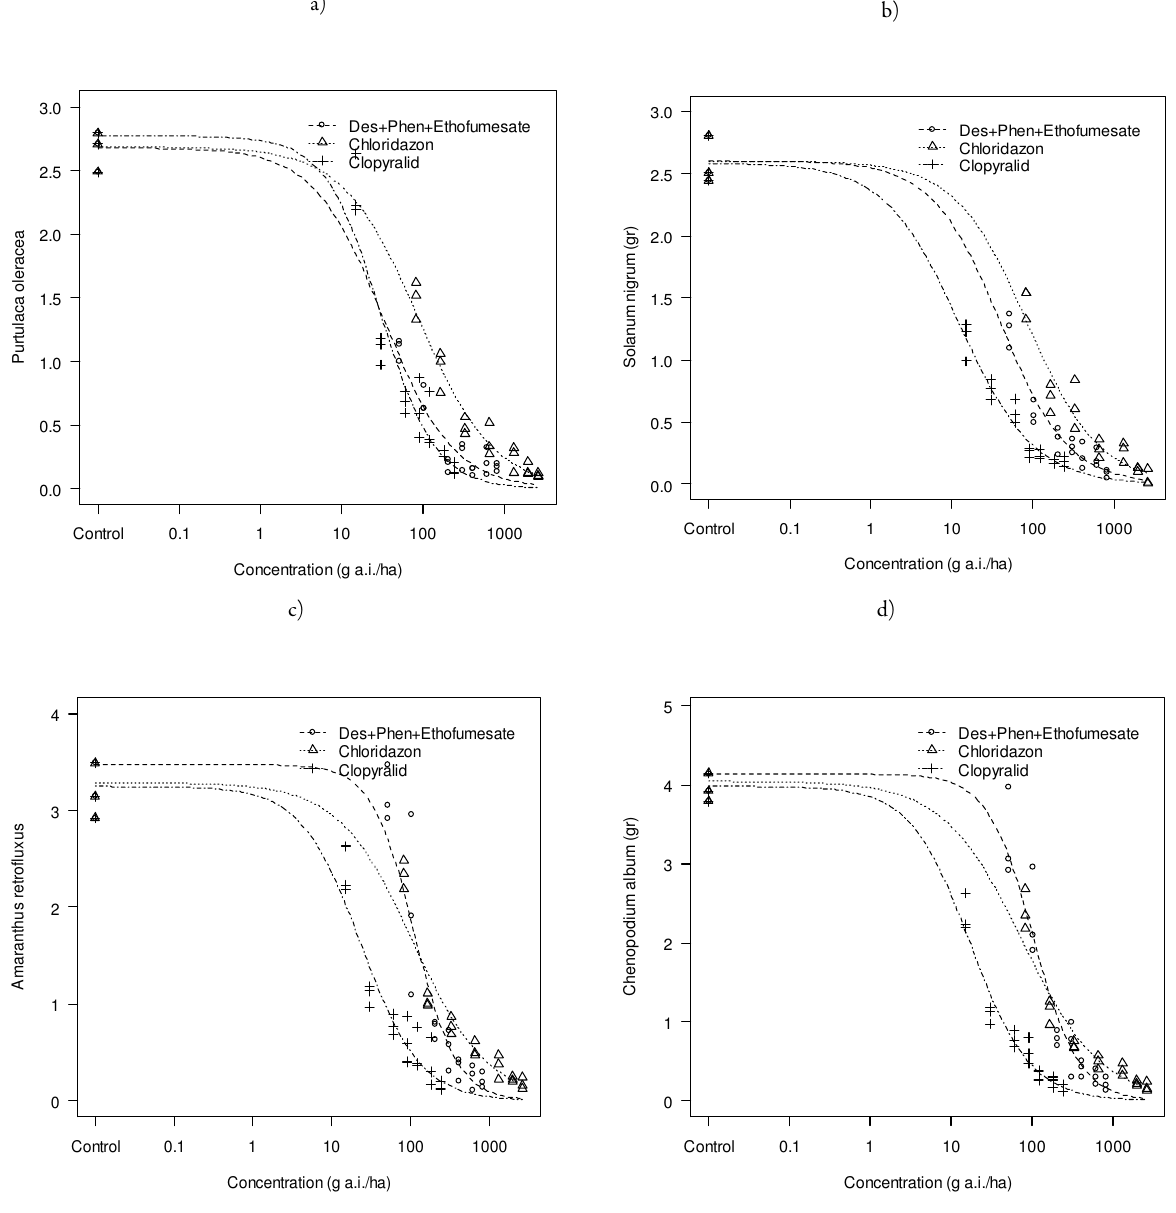
Fig. 1. Dose-response curves of Portulaca oleracea (a), Solanum nigrum (b), Amaranthus retroflexus (c) and Chenopodium album (d), aboveground dry matter (g per pot -1 ) to clopyralid and PSII inhibitor herbicides using the three parameter logistic model at four- to six-true leaf